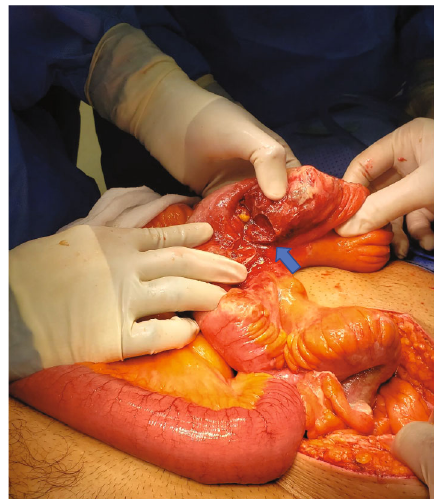
Figure 3: Intraoperative image depicting the site of ileal diverticular perforation on the mesenteric border.